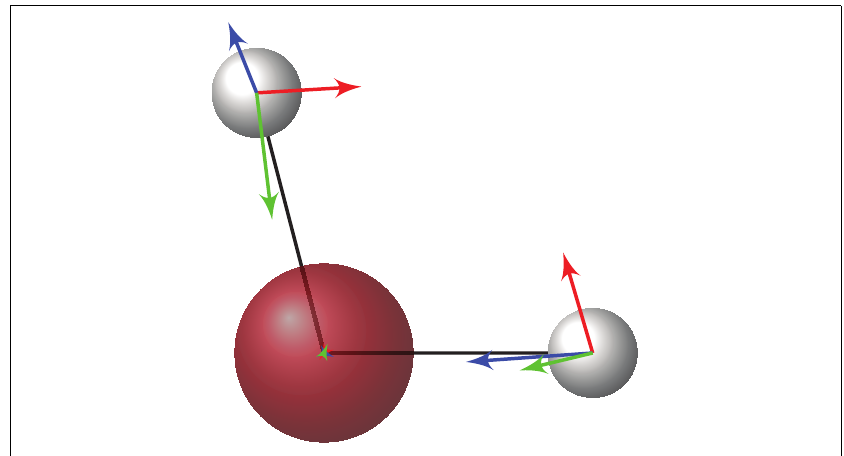
FIGURE 1 |The eigenvectors of the covariance matrix obtained with the noisy force components evaluated byVMC .These eigenvectors correspond to the three vibrational modes of the water monomer: bending (red), symmetrical (green), and asymmetrical (blue) stretching.The smallest eigenvalue corresponds to the lowest frequency vibrational mode